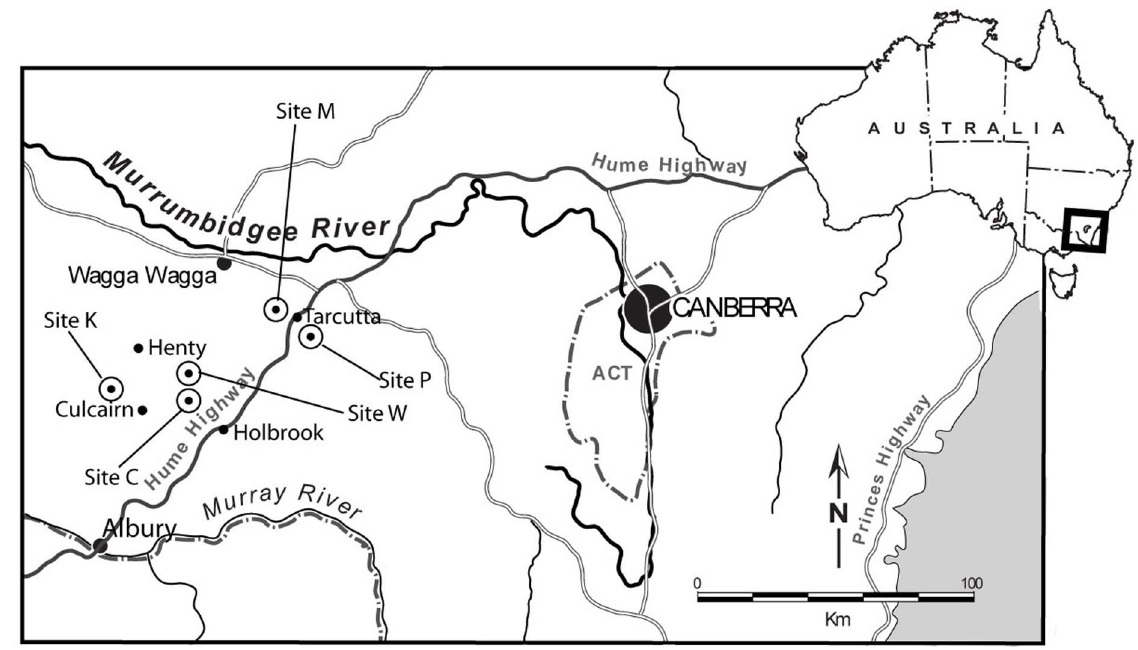
Figure 1. Location of the five study areas (C, K, M, P and W) used in radio-tracking the Squirrel Glider.